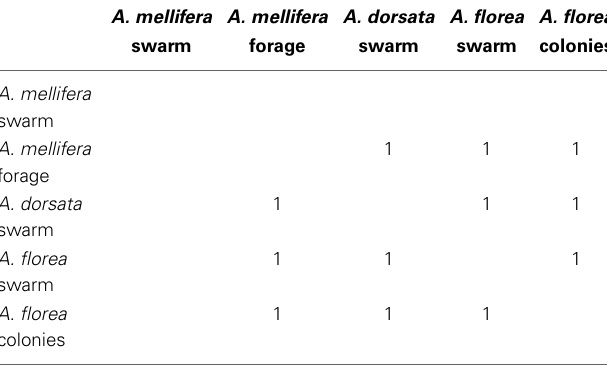
Table 8 | Fourth most frequent outcome of randomization analysis (575 occurrences out of 10,000 randomizations).